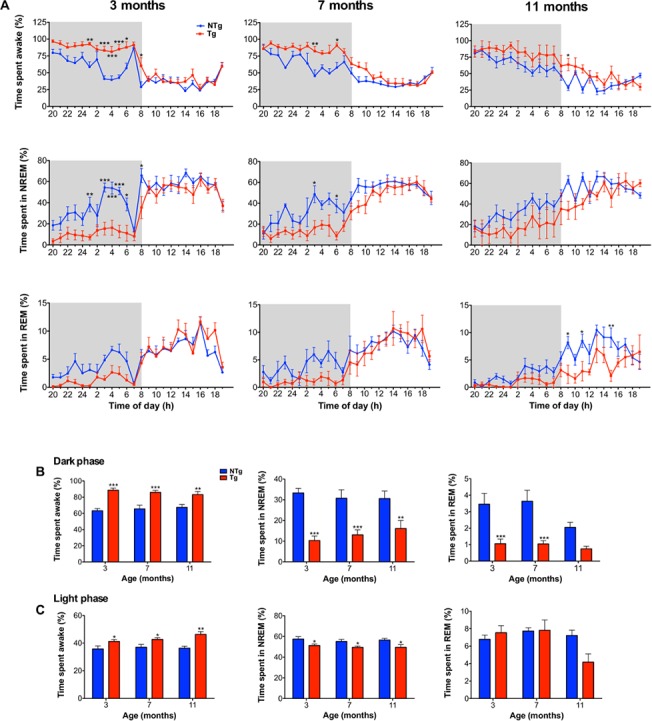
TgCRND8 mice show sleep-wake cycle disruption at early and advanced pathological stages.Hourly time courses (A) and cumulative percent duration (B and C) of wake, NREM and REM sleep across the light and dark phases at 3 (NTg n = 7, Tg n = 8), 7 (NTg n = 5, Tg n = 7) and 11(NTg n = 6, Tg n = 4) months of age. (B) During the dark phase, 3, 7 and 11-month-old TgCRND8 spend more time awake and less time in NREM sleep in comparison to NTg. Three and 7-month-old TgCRND8 mice also show a significant decrease in the percent time spent in REM sleep during the dark phase in comparison to NTg. (C) During the light phase, 3, 7 and 11-month-old TgCRND8 spend more time awake and less time in NREM sleep in comparison to NTg. Total time spent in REM sleep did not differ significantly between TgCRND8 and NTg during the light phase, at all ages studied. Error bars represent SEM. Panel A was analyzed by two-way ANOVA, followed by Bonferroni test for multiple comparisons. Panels B and C were analyzed by two-way ANOVA, followed by Tukey’s post-hoc test, * P<0.05, ** P<0.01, ***P<0.001.